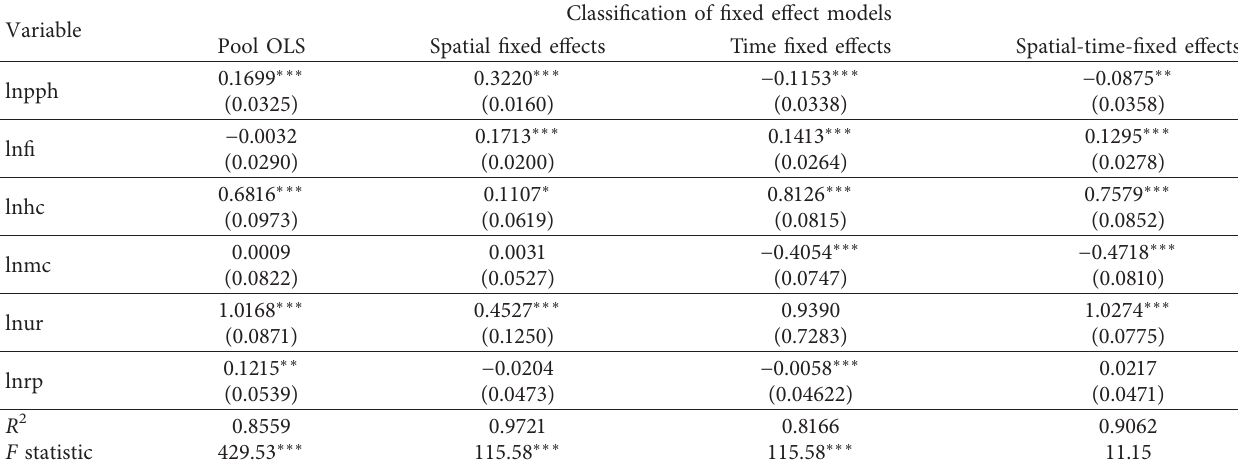
Table 4: Estimation results of nonspatial panel